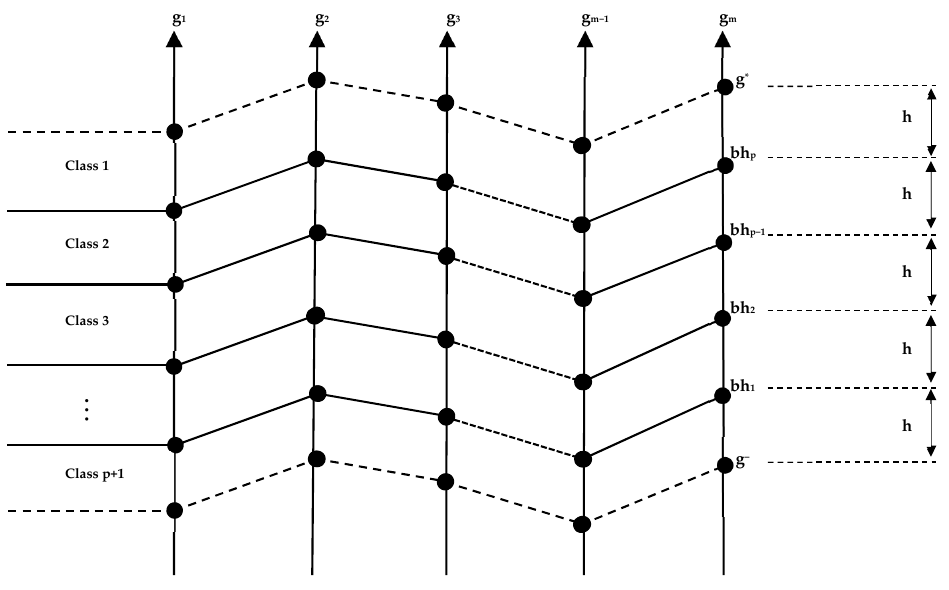
Figure 2. Procedure bh of the ELECTRE-MOr method.